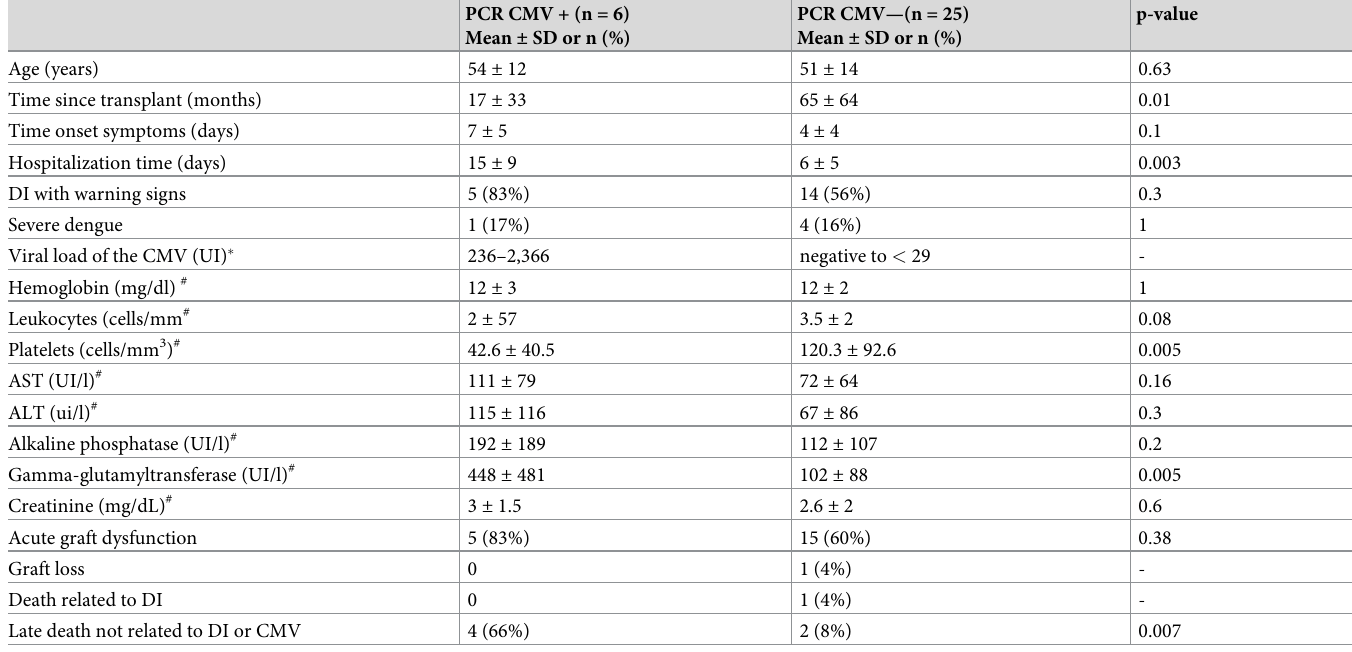
Table 4. Dengue infection in KTx subgroup which developed CMV viremia compared with KTx subgroup with PCR